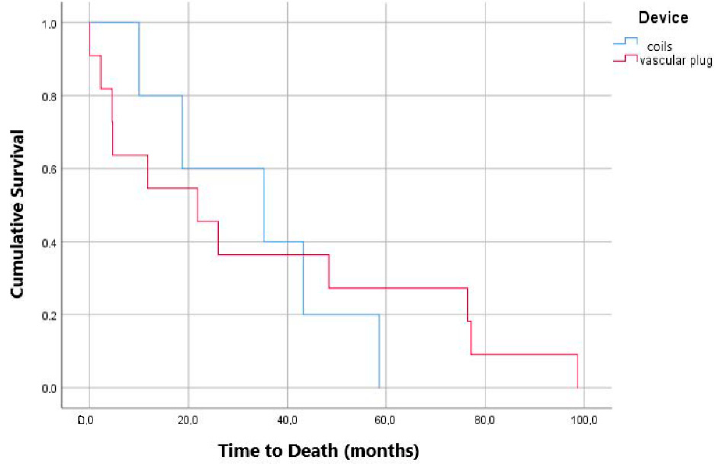
Figure 3. Kaplan-Meier curve showing relationship of mortality of patients treated with coils and vascular plug.